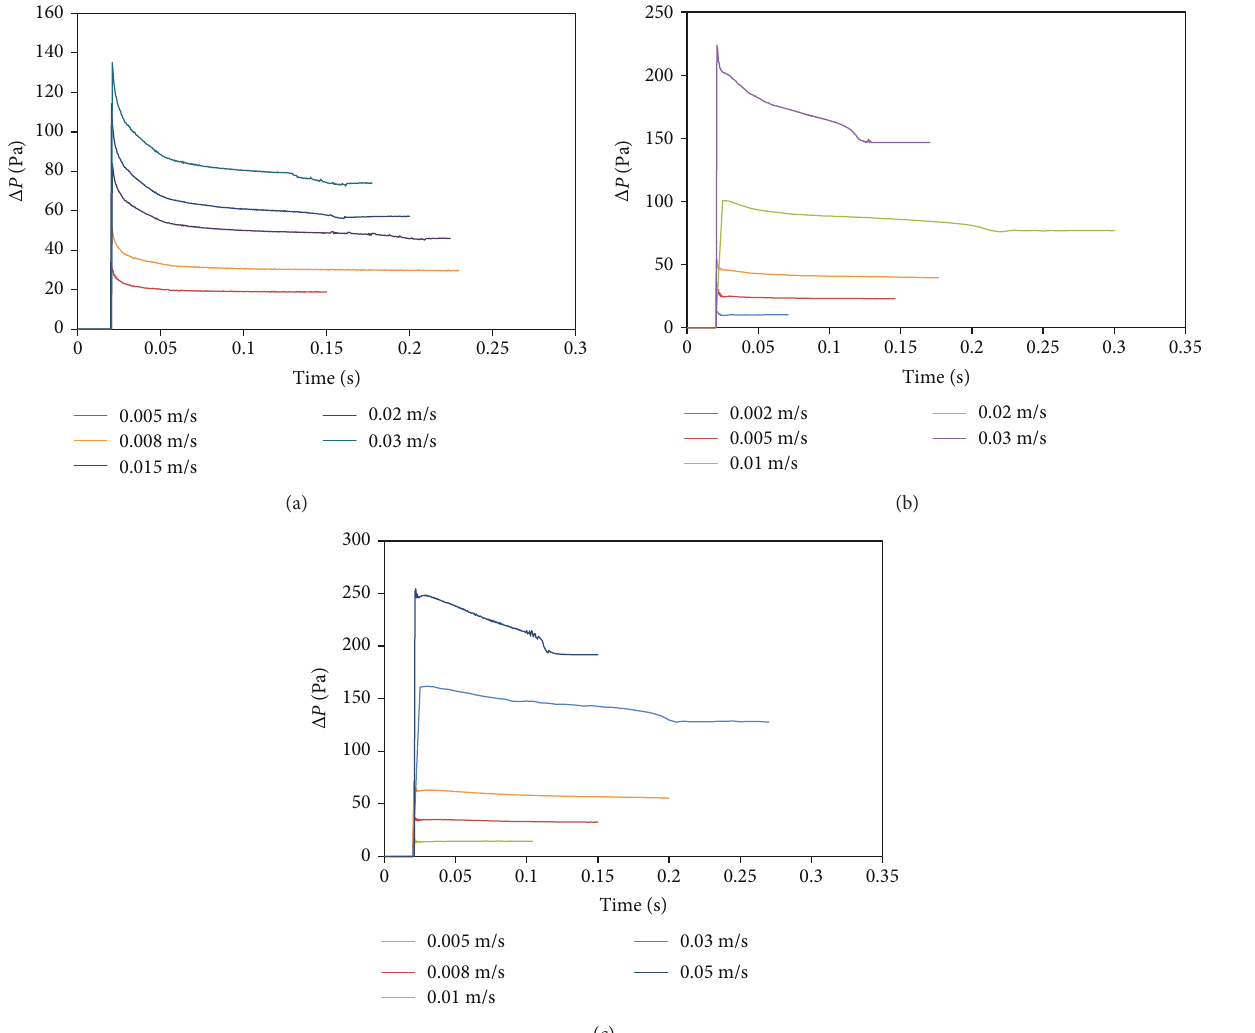
Figure 7: Pressure drops curves for di ff erent velocities in capillaries: (a) triangle cross section, (b) quadrilateral cross section, and (c) pentagon cross